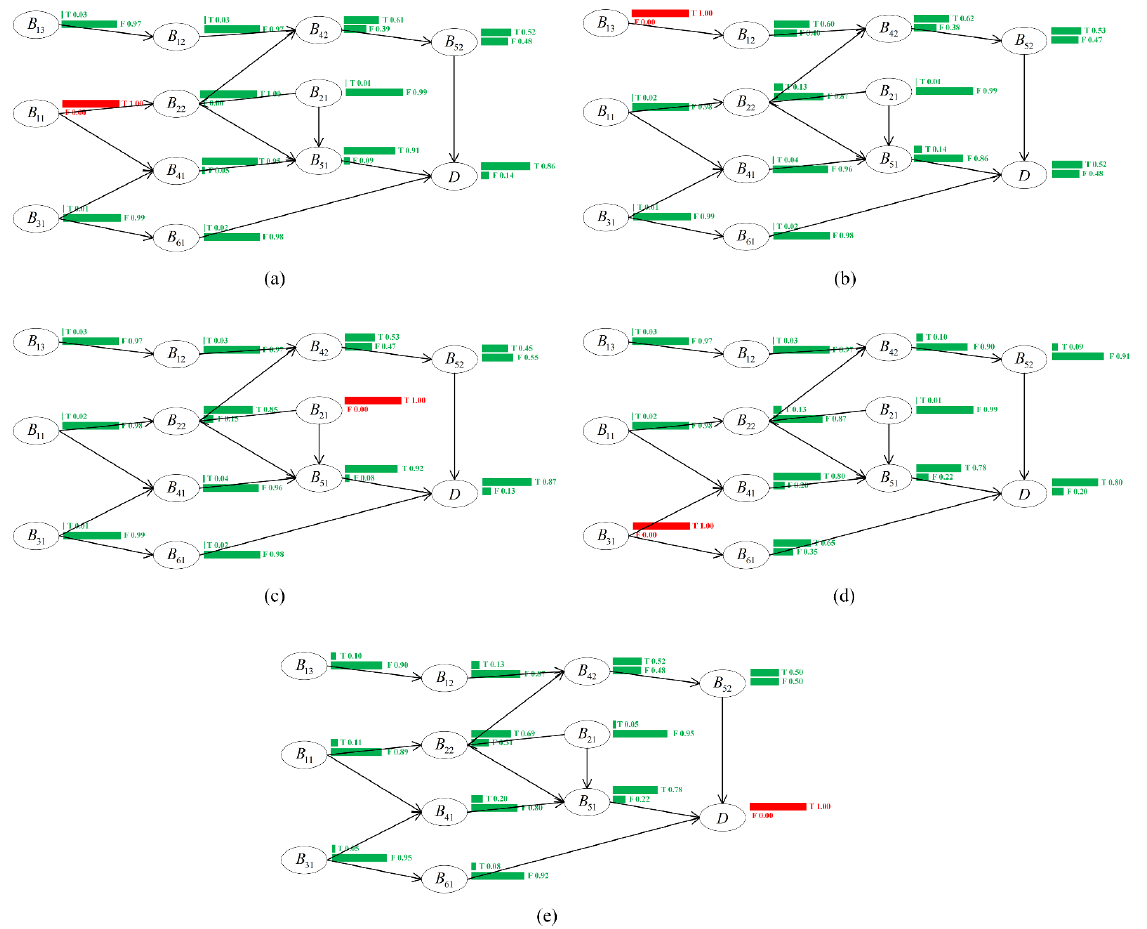
Figure 6. Process of Bayesian network reasoning for the risk of delayed delivery. ( a ) The occurrence of B 11 as evidence. ( b ) The occurrence of B 13 as evidence. ( c ) The occurrence of B 21 as evidence. ( d ) The occurrence of B 31 as evidence. ( e ) The occurrence of D as